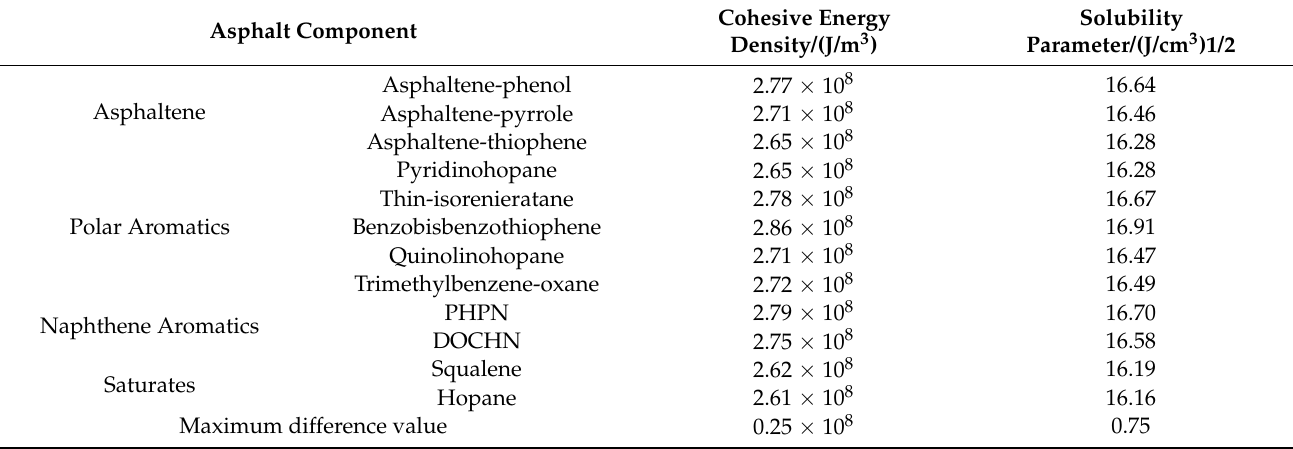
Table 2. The cohesive energy density and solubility parameters of the asphalt components.